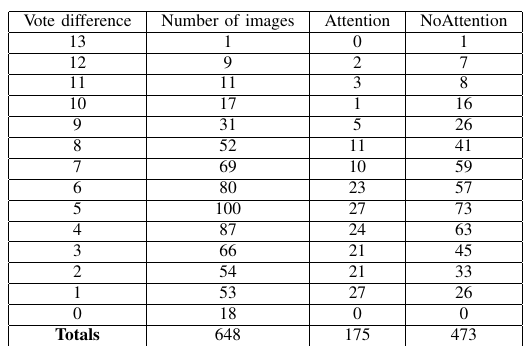
of Attention/NoAttention labels, were discarded for training; and only those postures with a clear agreement among raters ( vote difference ≥ 6 ) were selected, leaving a subset of 270 images, 55 labeled as Attention and 215 as NoAttention. These where used for training. S AMPLES SORTED BY VOTE DIFFERENCE .